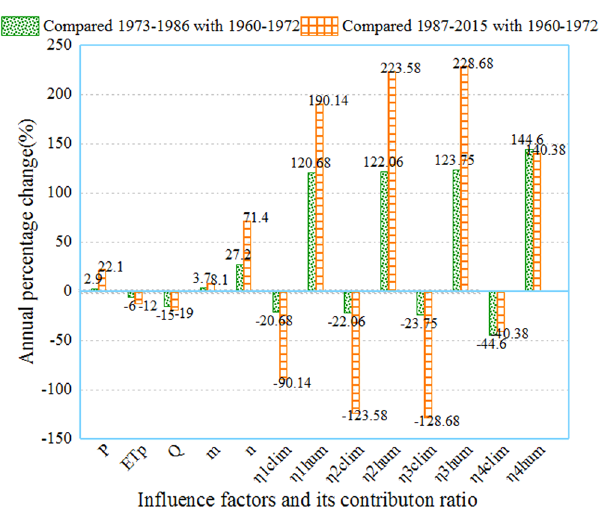
Figure 4. Barplot of annual runoff change in different periods (Note: η 1 contribution rates of climate change in Budyko, Fu. Choudhury equations and DMC, respectively. η 1